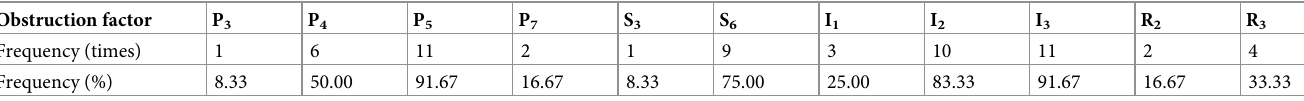
Table 14. Frequency of main obstacles to land-based ecological security in Xingtai city. Obstruction